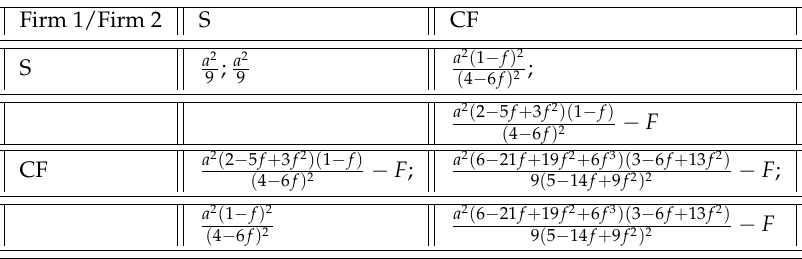
Figure 3. Matrix of payoffs with platform